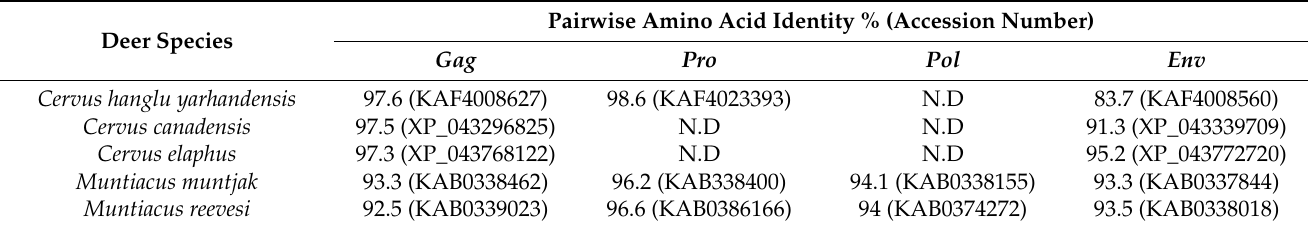
Table 2. Comparison of CERV β 1 ORFs and proteins from other deer species deposited in GenBank.